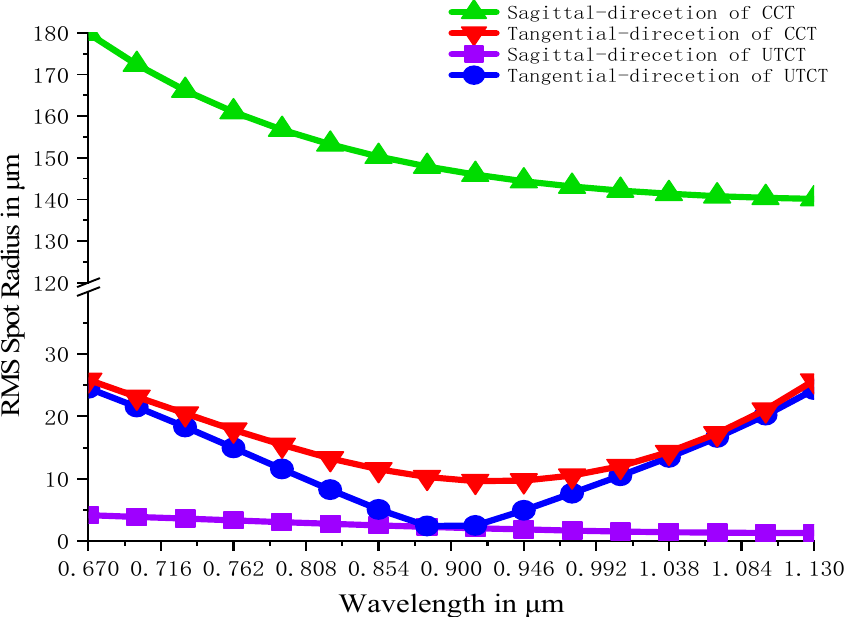
Figure 5. RMS spot radius versus wavelength for UTCT and CCT.